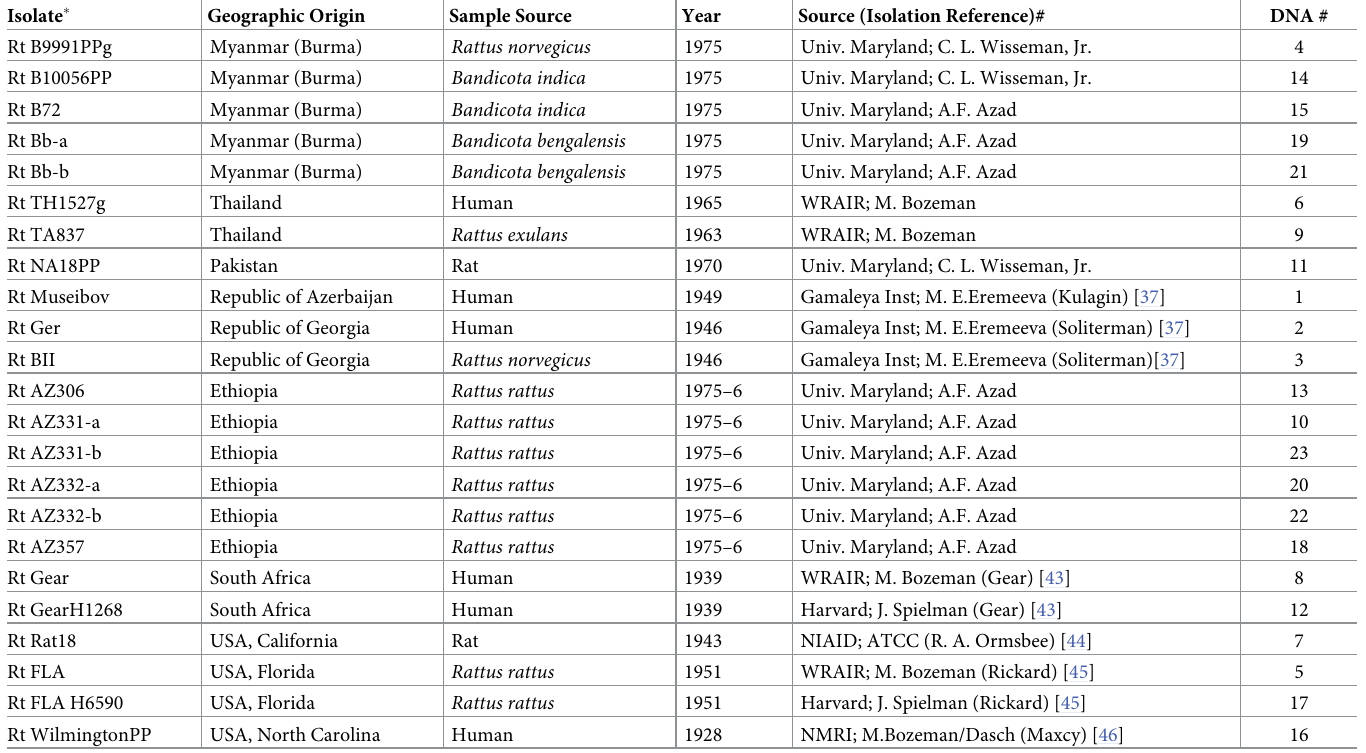
Table 1. Isolates of Rickettsia typhi (Rt) and details of their